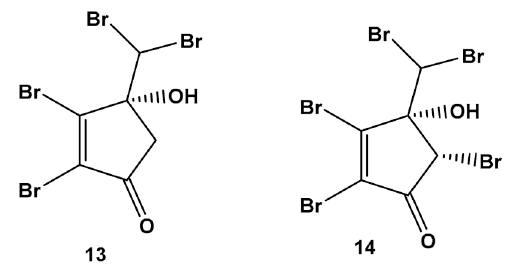
Figure 2. Chemical structures of two 2,3-dibromocyclopentone derivatives identified in Asparagospis taxiformis